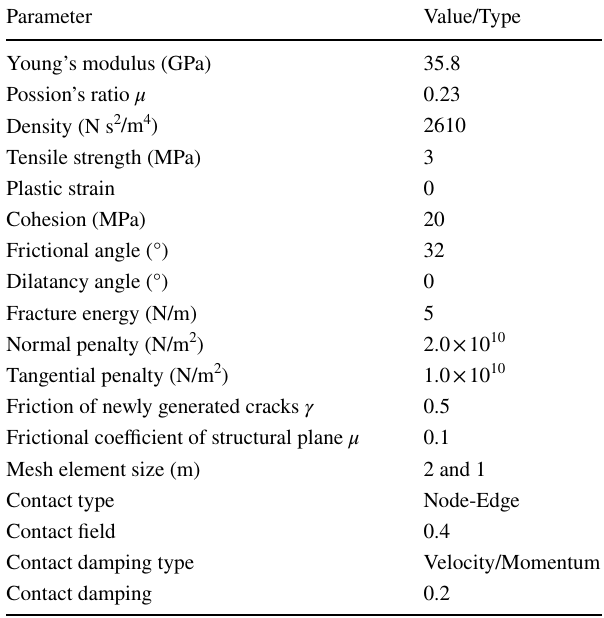
Table 1 Material properties of initial status adopted in the present numerical study (Feng et al. 2019a, 2019b,